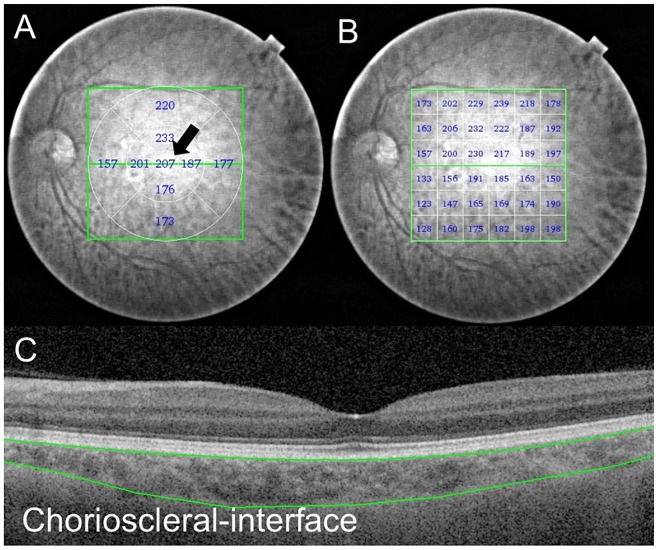
The choroidal thickness map of a 57-year-old normal male obtained using SS-OCT.The 3D raster scan protocol with 512A-scans ×256 B-scans was used to obtain the 3D imaging data for a 6×6-mm area. (A) The black arrow shows the central sector choroidal thickness as measured on the ETDRS grid within a 1×1-mm circular area. (B) The choroidal thickness values presented by the 6×6 rectangular grid map. Each value shows the mean choroidal thickness within a 1×1-mm square area. (C) Manual segmentation of the chorioscleral interface on the B-scan image. All 64 B-scan images were obtained for each subject.